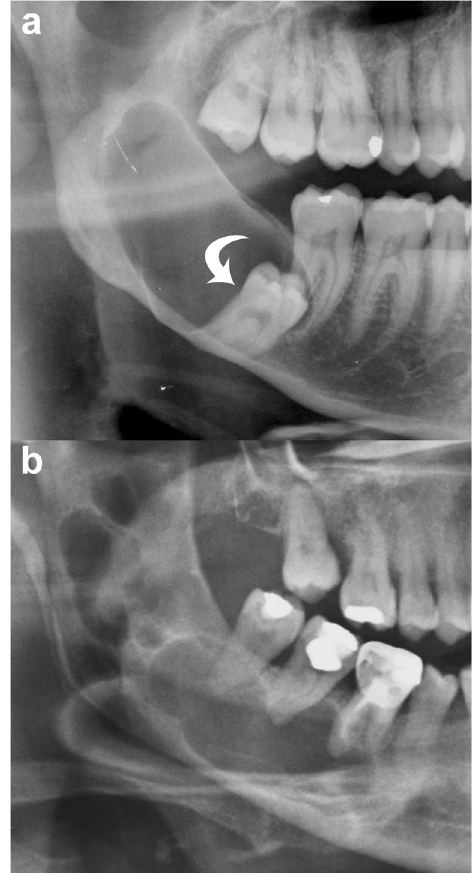
Fig. 1 Mandibular odontogenic keratocysts (OKCs). a Cropped panoramic radiograph shows a unilocular lesion in the posterior mandible and ramus that determines mesial displacement of the impacted third molar ( curved arrow ). b Cropped panoramic radiograph demonstrates a multilocular lesion occupying the posterior mandible and ramus with a soap-bubble pattern